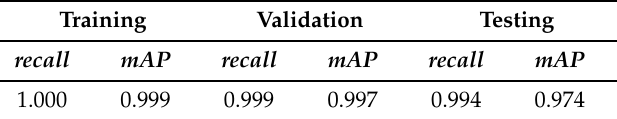
Table 3. Hand detection